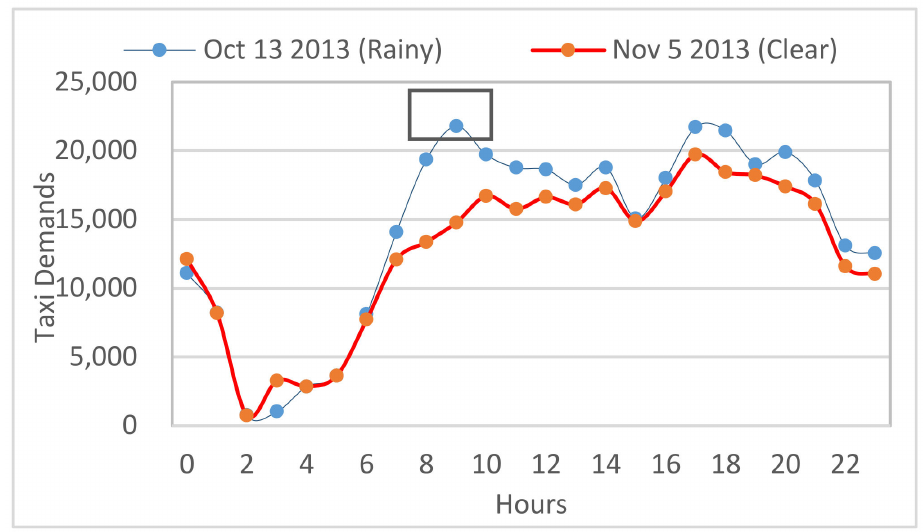
Figure 11. Weather Influence on Taxi demands.